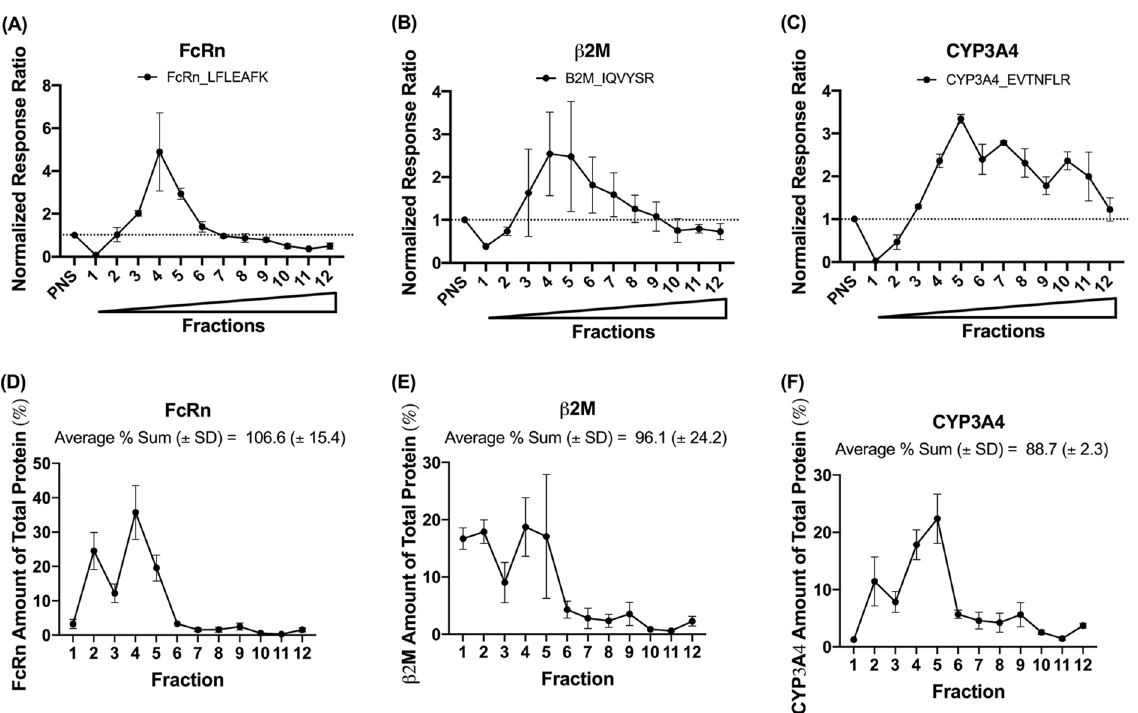
Figure 5. Distribution ( A – C ) and recovery ( D – F ) for three case study proteins in the isolated sucrose fractions. 20 µg of total protein were digested for each sample. Each fraction’s response ratio was normalized to its corresponding PNS response ratio. Circles represent the average normalized response ratio from three human liver donors, and error bars stand for the standard deviation. Wedge indicates increasing sucrose % from fraction 1 to